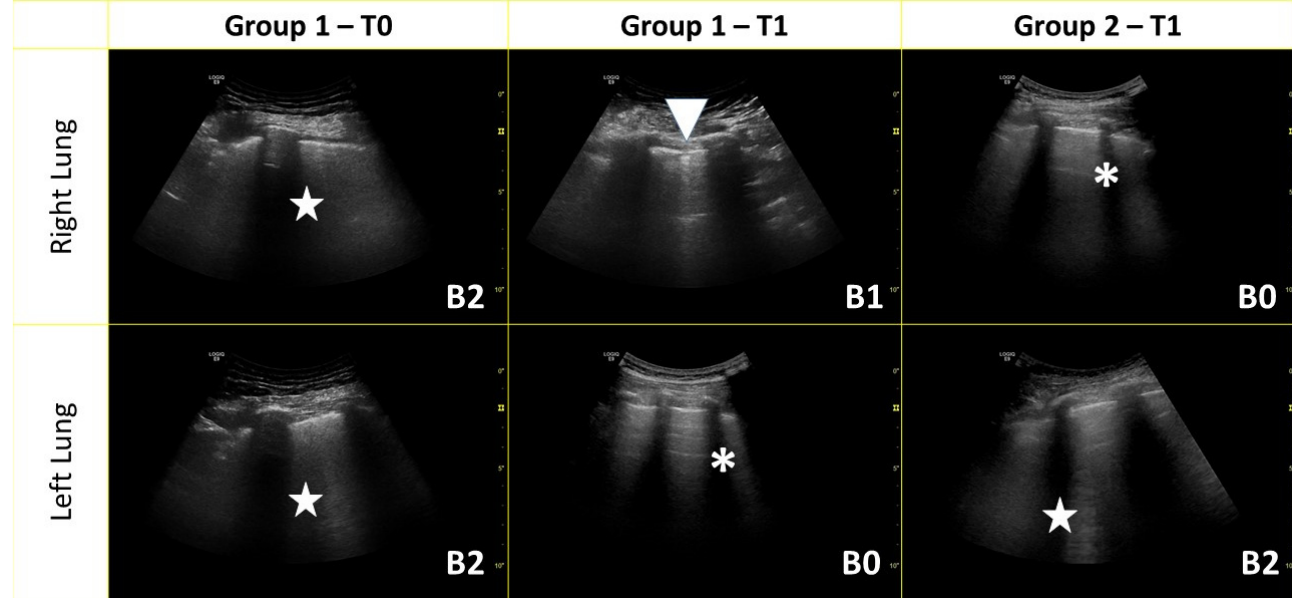
Figure 1. Representative images from one patient for each group (at the different time points) from the right and left lungs used to evaluate the lung ultrasound (LUS) score. The score for each segment is reported at the bottom of each panel. Multiple B-line conglomerations are indicated with ( ), B- lines with little subpleural consolidation are indicated with ( ) while ( ) indicates A-lines.